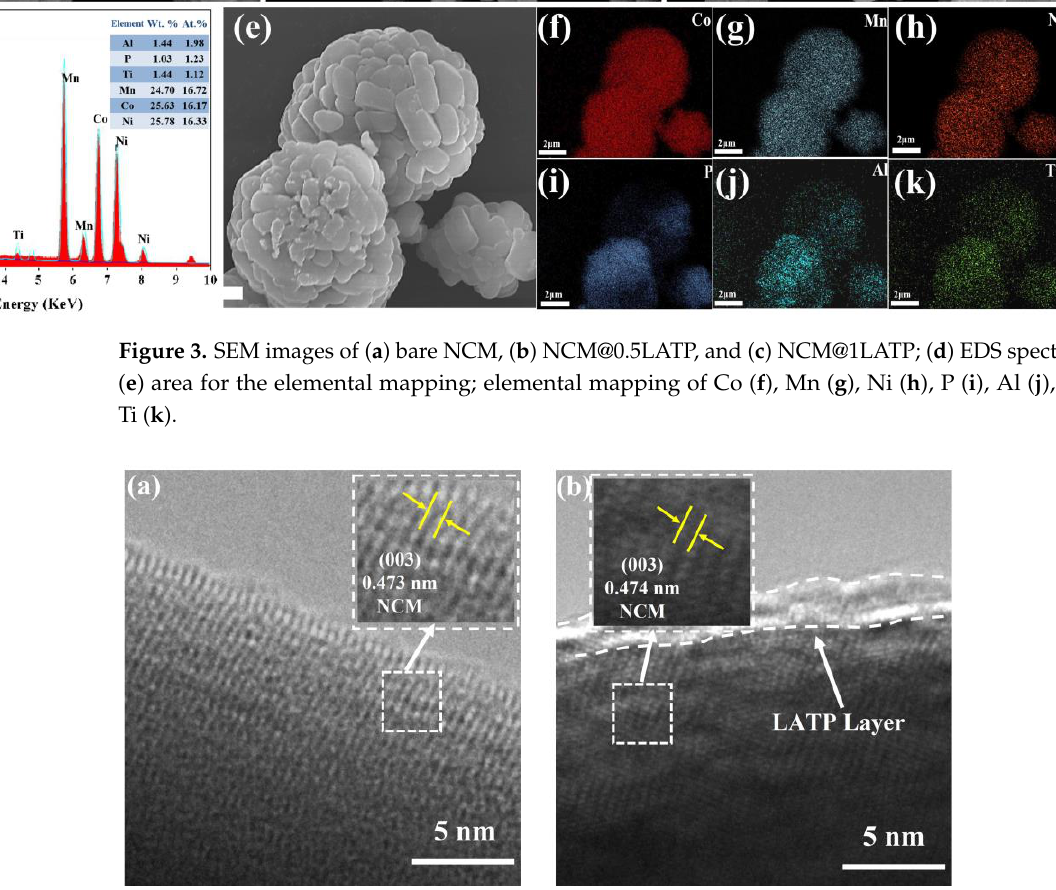
Figure 3. SEM images of ( a ) bare NCM, ( b ) NCM@0.5LATP, and ( c ) NCM@1LATP; ( d ) EDS spec- trum; ( e ) area for the elemental mapping; elemental mapping of Co ( f ), Mn ( g ), Ni ( h ), P ( i ), Al ( j ), and Ti ( k ).